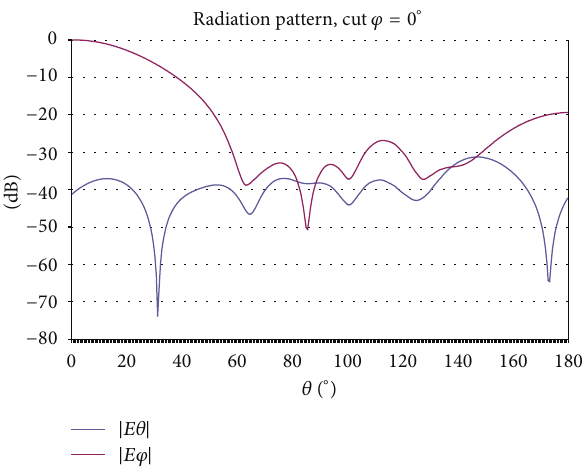
Figure 17: Radiation pattern of the rectangular horn.